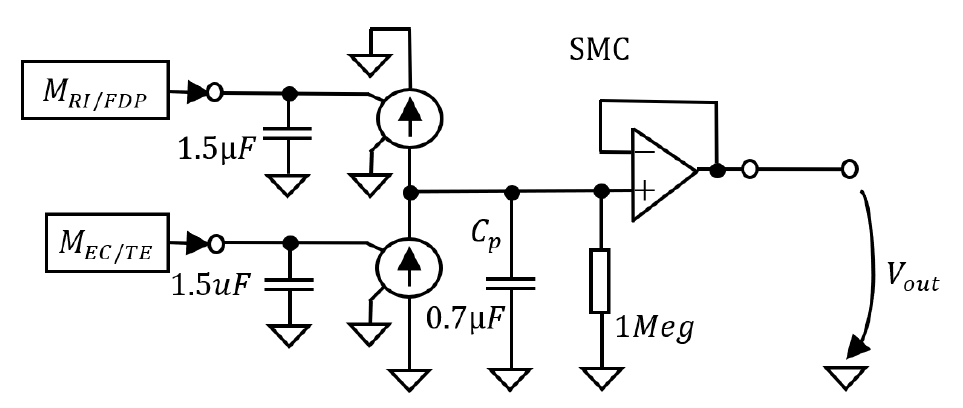
Figure 5. The circuit for modelling the joint rotation when the junction is actuated by SMA wire.